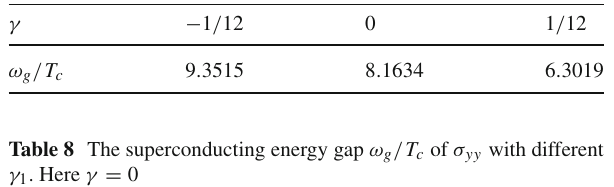
Table 9 The values of log 10 [ σ 0 ] and log 10 [ τ ] from the fitting points in 4 derivative theory with different γ . Here γ 1 = 0